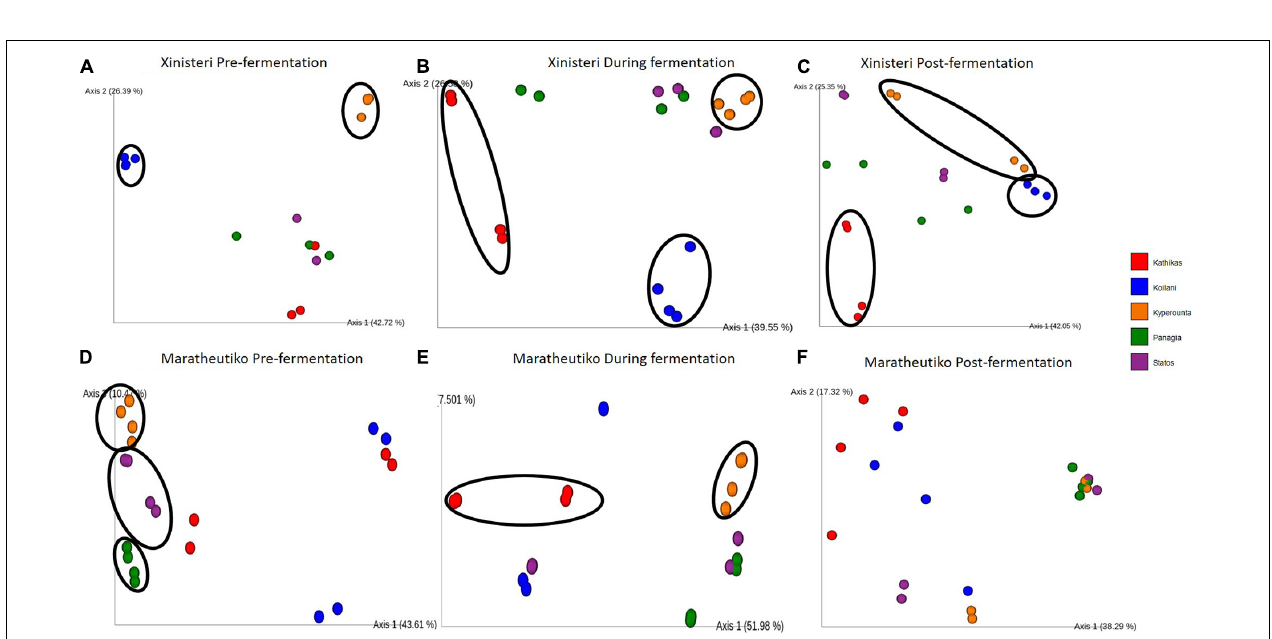
FIGURE 3 | Comparison of the microbial alpha diversity based on the Shannon index during the three stages of fermentation (pre-fermentation, during fermentation, and post-fermentation). (A) Fungal diversity of the variety Xynisteri; (B) fungal diversity of the variety Maratheftiko; (C) bacterial diversity for the variety Xynisteri; (D) bacterial diversity for the variety Maratheftiko. The o symbol represents the outliers from the median.